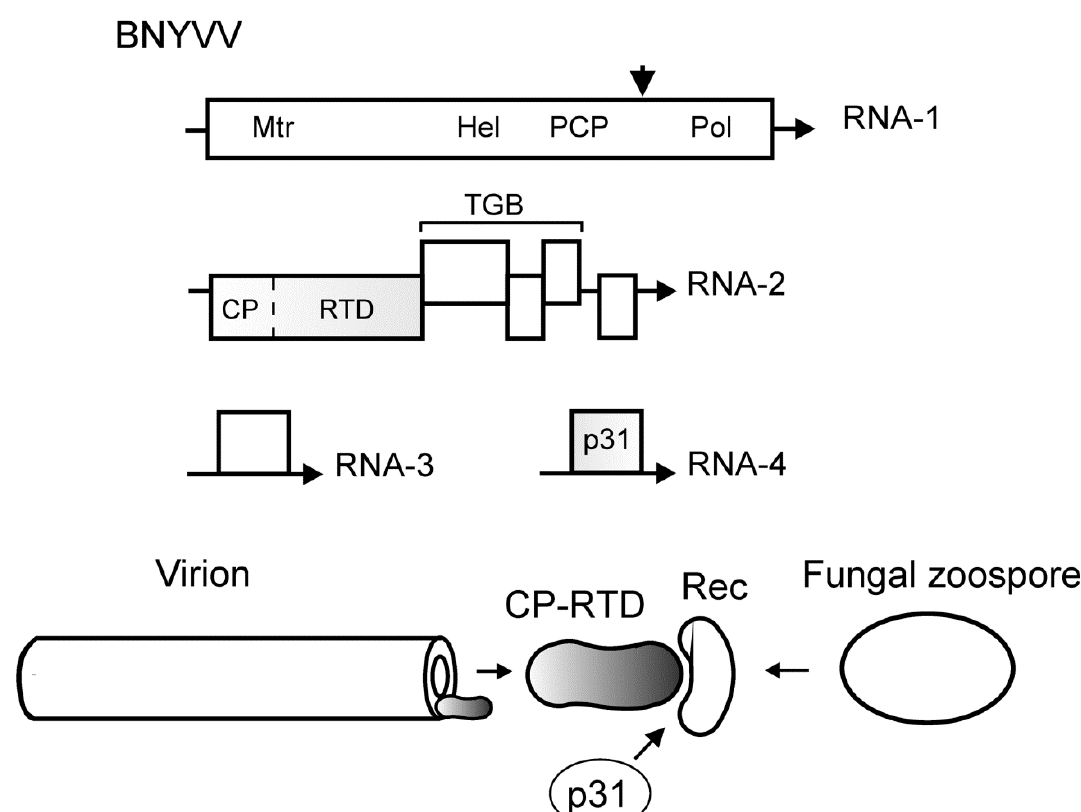
Figure 3. Top, scheme of the RNA genome of beet necrotic yellow vein virus (BNYVV). The genome is divided among RNA-1, RNA-2, RNA-3, and RNA-4. Arrows indicate the 3 ′ -end of RNA. Encoded proteins and protein domains: Mtr, methyltransferase; Hel, helicase; PCP, papain-like cysteine proteinase (arrowhead, the cleavage site); Pol, RNA-dependent RNA polymerase; TGB, triple gene block coding for cell-to-cell movement proteins; CP, capsid protein (dotted line, leaky stop codon); RTD, readthrough domain. The genes involved in transmission are shaded. Bottom, protein interactions in benyvirus transmission by fungal zoospores. CP-RTD is incorporated into one end of the rod-like virion and, with assistance of the BNYVV p31, interacts with a receptor (Rec) in Polymyxa betae zoospores to drive the virus transmission.